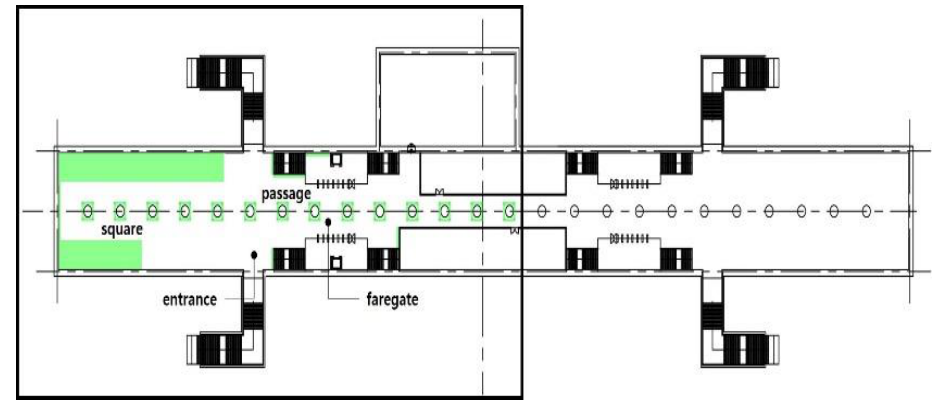
Figure 2. The Plan and Interior Landscape Composition Range of Subway Station Interior Landscape Model.